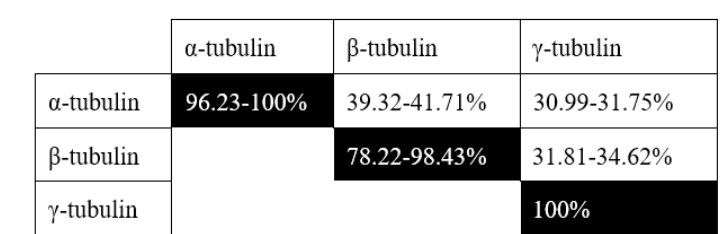
Figure 2. Grouped homology among human tubulin isoforms. Range shown in the homology of an isoform with itself refers to the minimal and maximal homology among sub-isoforms (see Table S1 for full details)